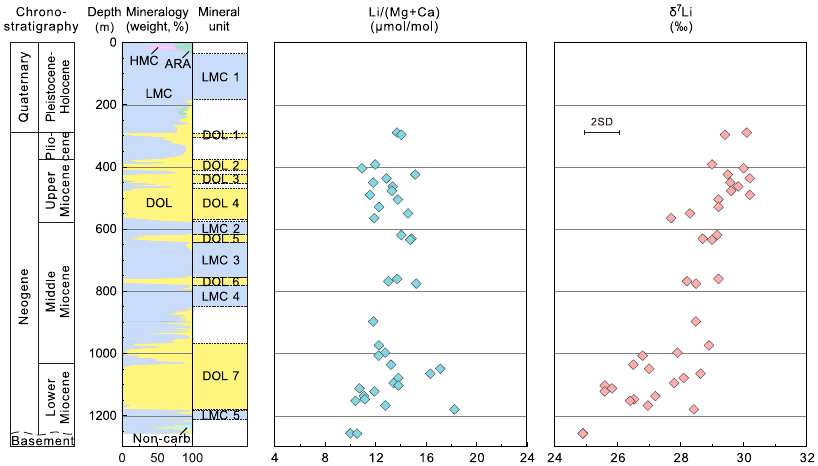
Fig. 1 Lithium isotope compositions ( δ 7 Li) and Li/(Mg + Ca) ratios in dolostones of the XK-1 core in the South China Sea. The chronostratigraphic units and mineralogical composition variations are from our previous work 24 . ARA: aragonite, HMC: high-magnesium calcite, LMC: low-magnesium calcite, DOL: dolomite, and Non-carb: non-carbonate minerals. LMC # or DOL # denotes calcite or dolomite units with calcite or dolomite content higher than 90%. The error bar represents the δ 7 Li long-term analytical precision at the Plasma Mass Spectrometry Laboratory, University of North Carolina – Chapel Hill, which is better than 1.1 ‰ (2 SD) 29